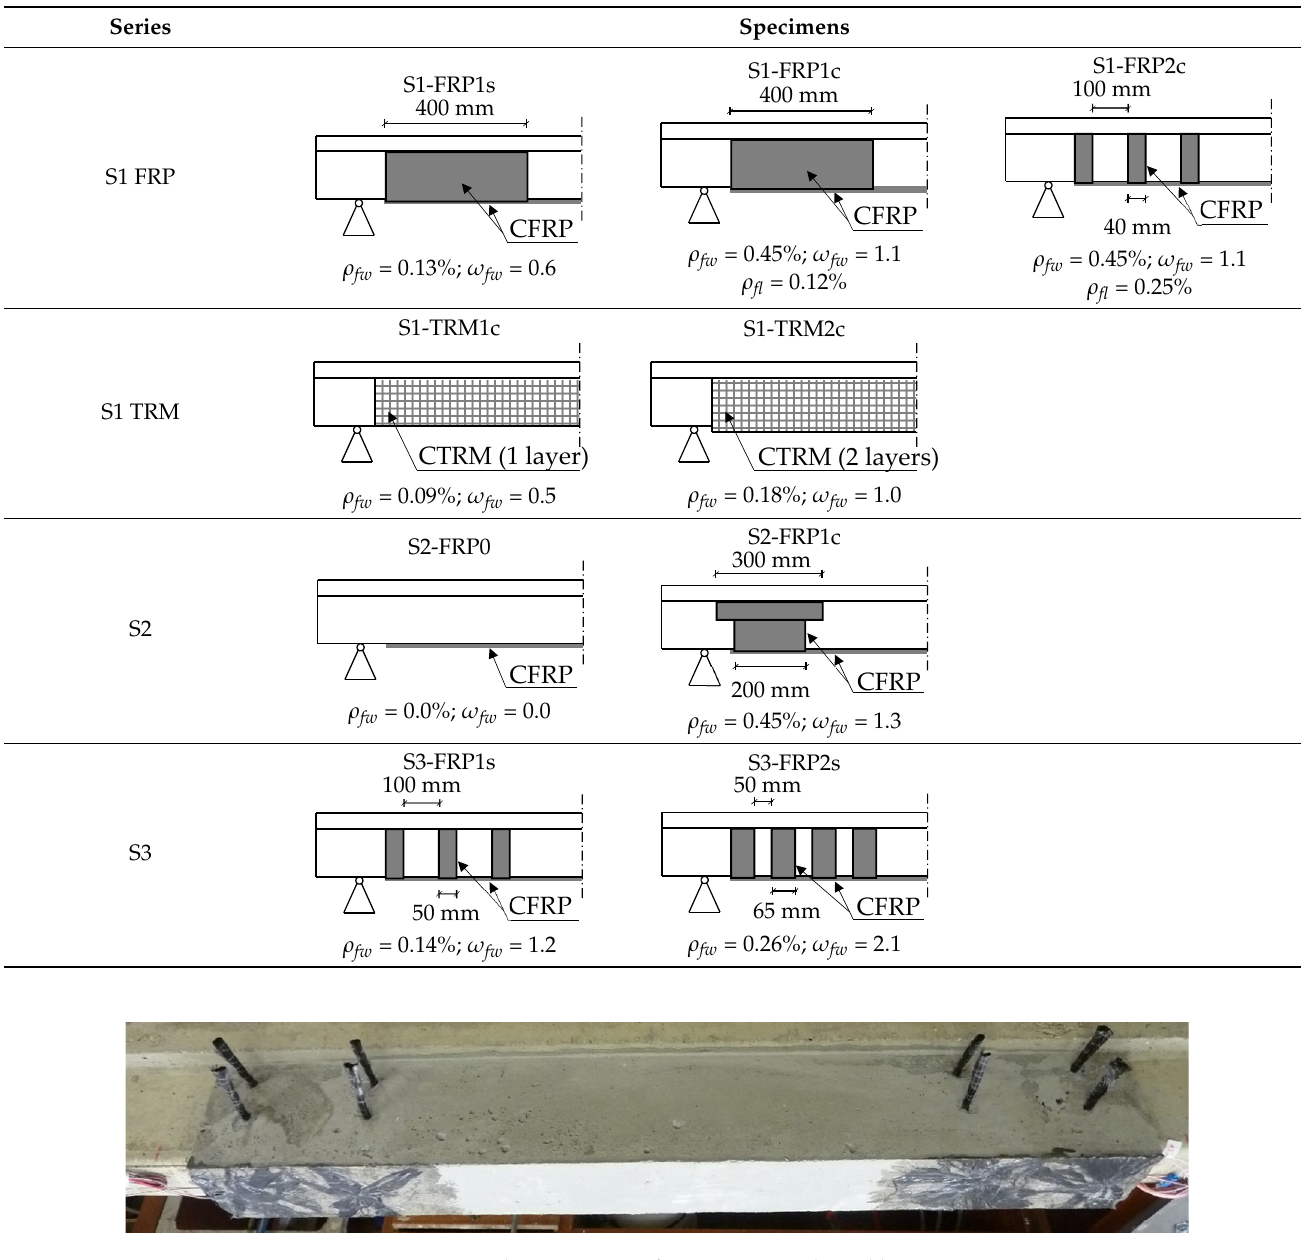
Table 4. Retrofit detailing for all specimens.